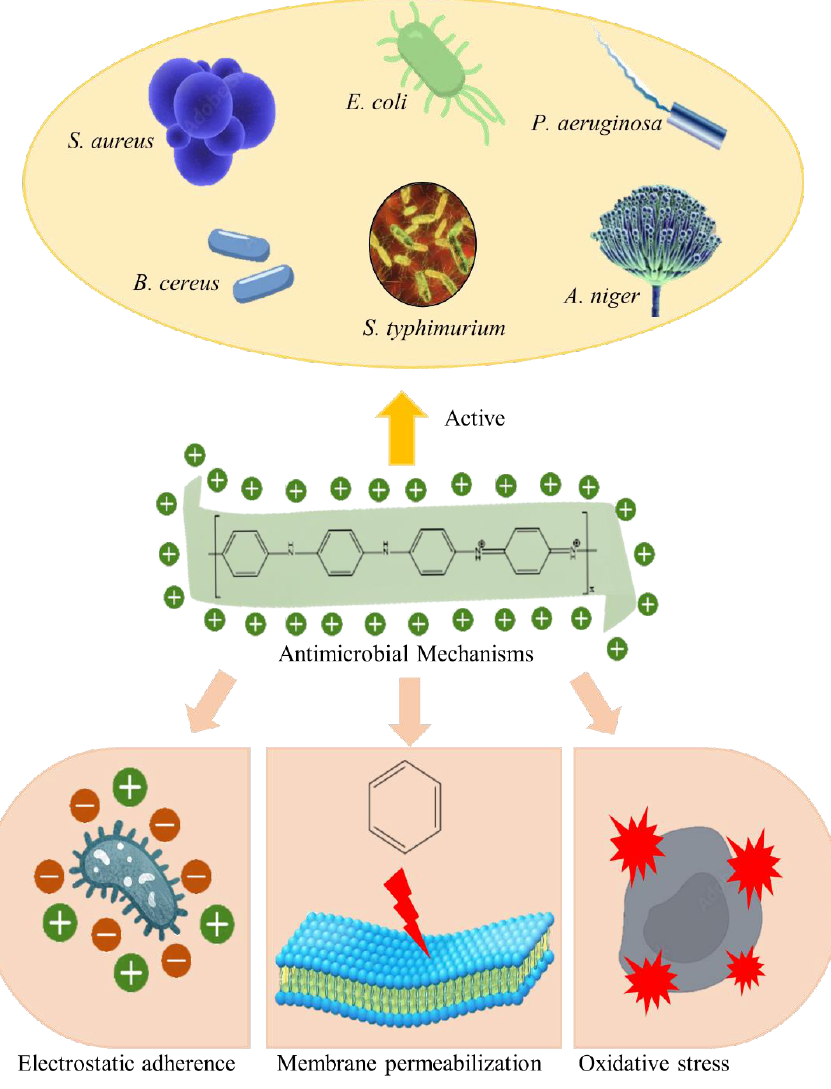
Figure 8. Antimicrobial activity of PANI.